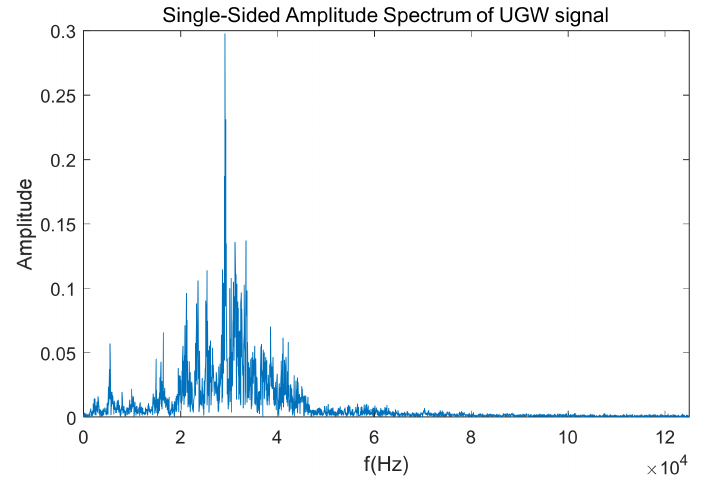
Figure 10. Frequency-domain representation of a train of UGW pulses for an occupied track